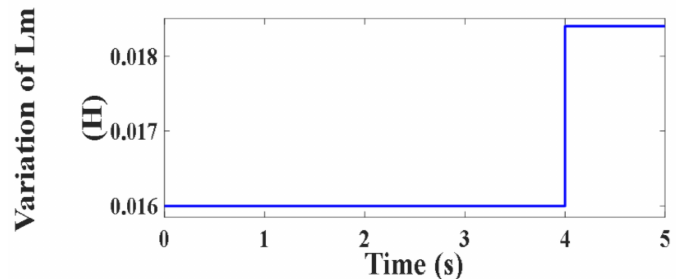
Figure 114. Variation of L m (H).